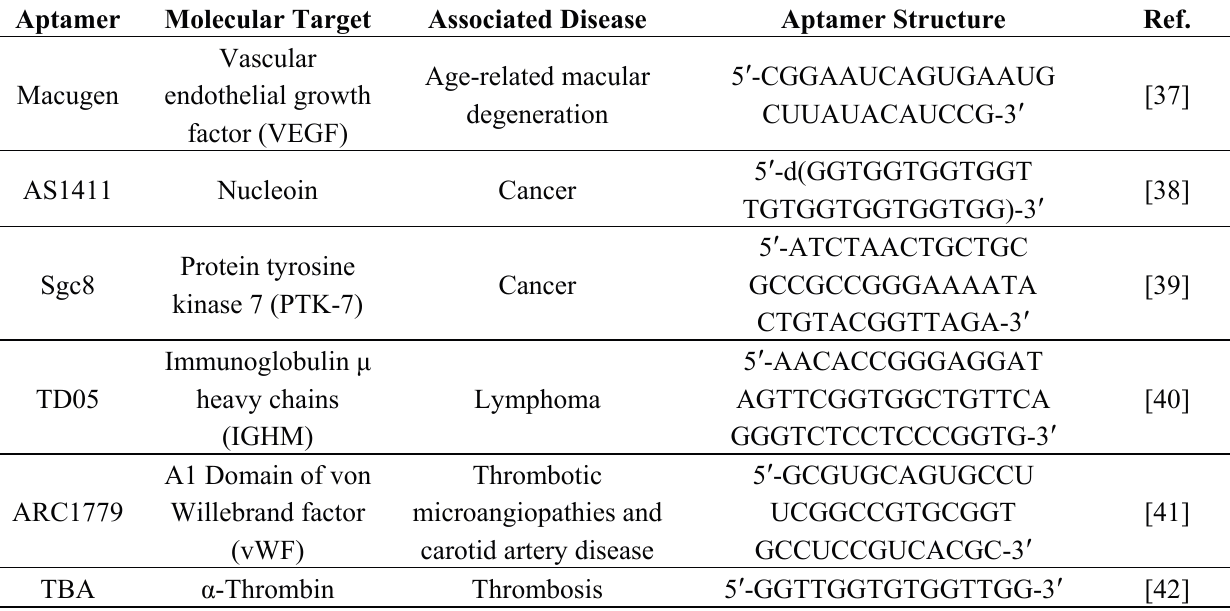
Table 1. Example of nucleic acid